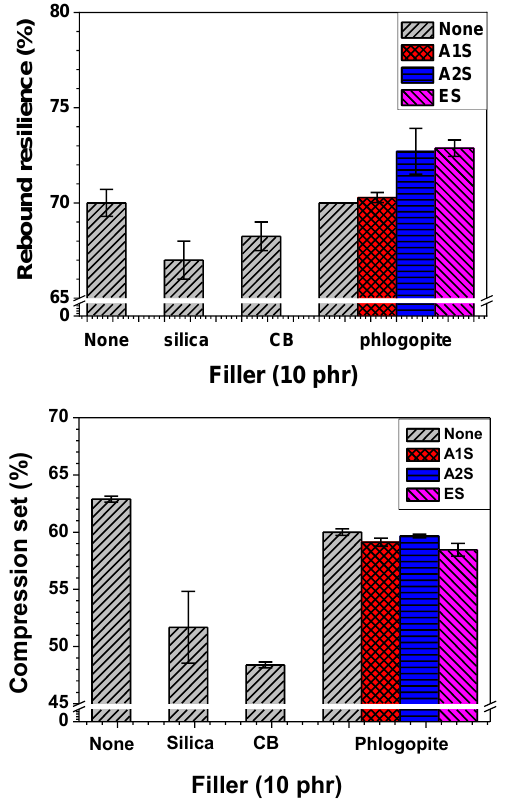
Figure 6. Rebound resilience and compression set of the NR/EPDM blend and composites with different fillers and functionalization types (amino- and epoxide-functionalized) for phlogopite.